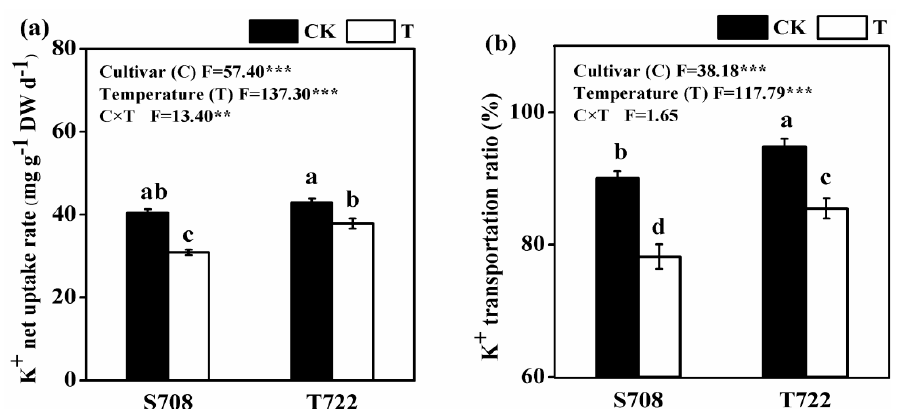
Figure 3. K + net uptake rate and K + transportation ratio of S708 and T722 cultivars under normal (CK, 25/18 ° C) and sub-optimal temperature (T, 15/10 ° C) conditions. ( a ) K + net uptake rate during days 5–10 of growth. ( b ) The percentage of net increased K + in shoots to net increased total K + in the entire plant during the days 5–10 of growth. Data are the means with standard deviation shown by vertical bars (n = 3 representing 3 biological replicates). The different small letters above the bars represent significant differences attested by the Tukey’s HSD test ( p < 0.05). F -values from two-way ANOVA analysis of effects of cultivar and temperature treatment on K + net uptake rate and K + transportation ratio. * p ≤ 0.05, ** p ≤ 0.01, *** p ≤ 0.001.